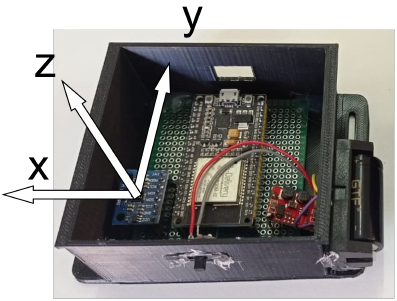
Figure 4. Sensors with the reference coordinate